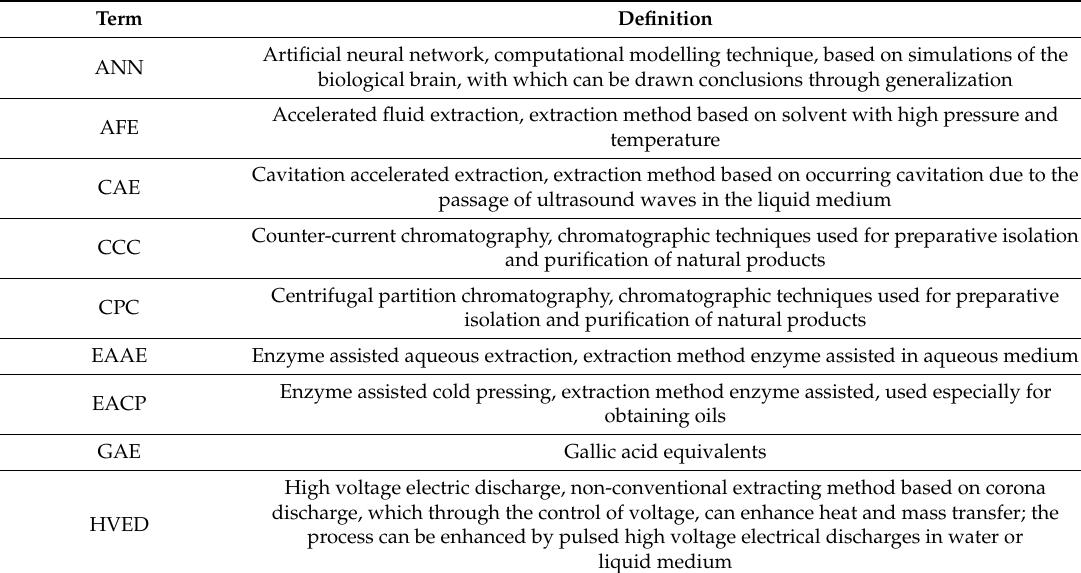
Table 1. Definitions of the terms and techniques